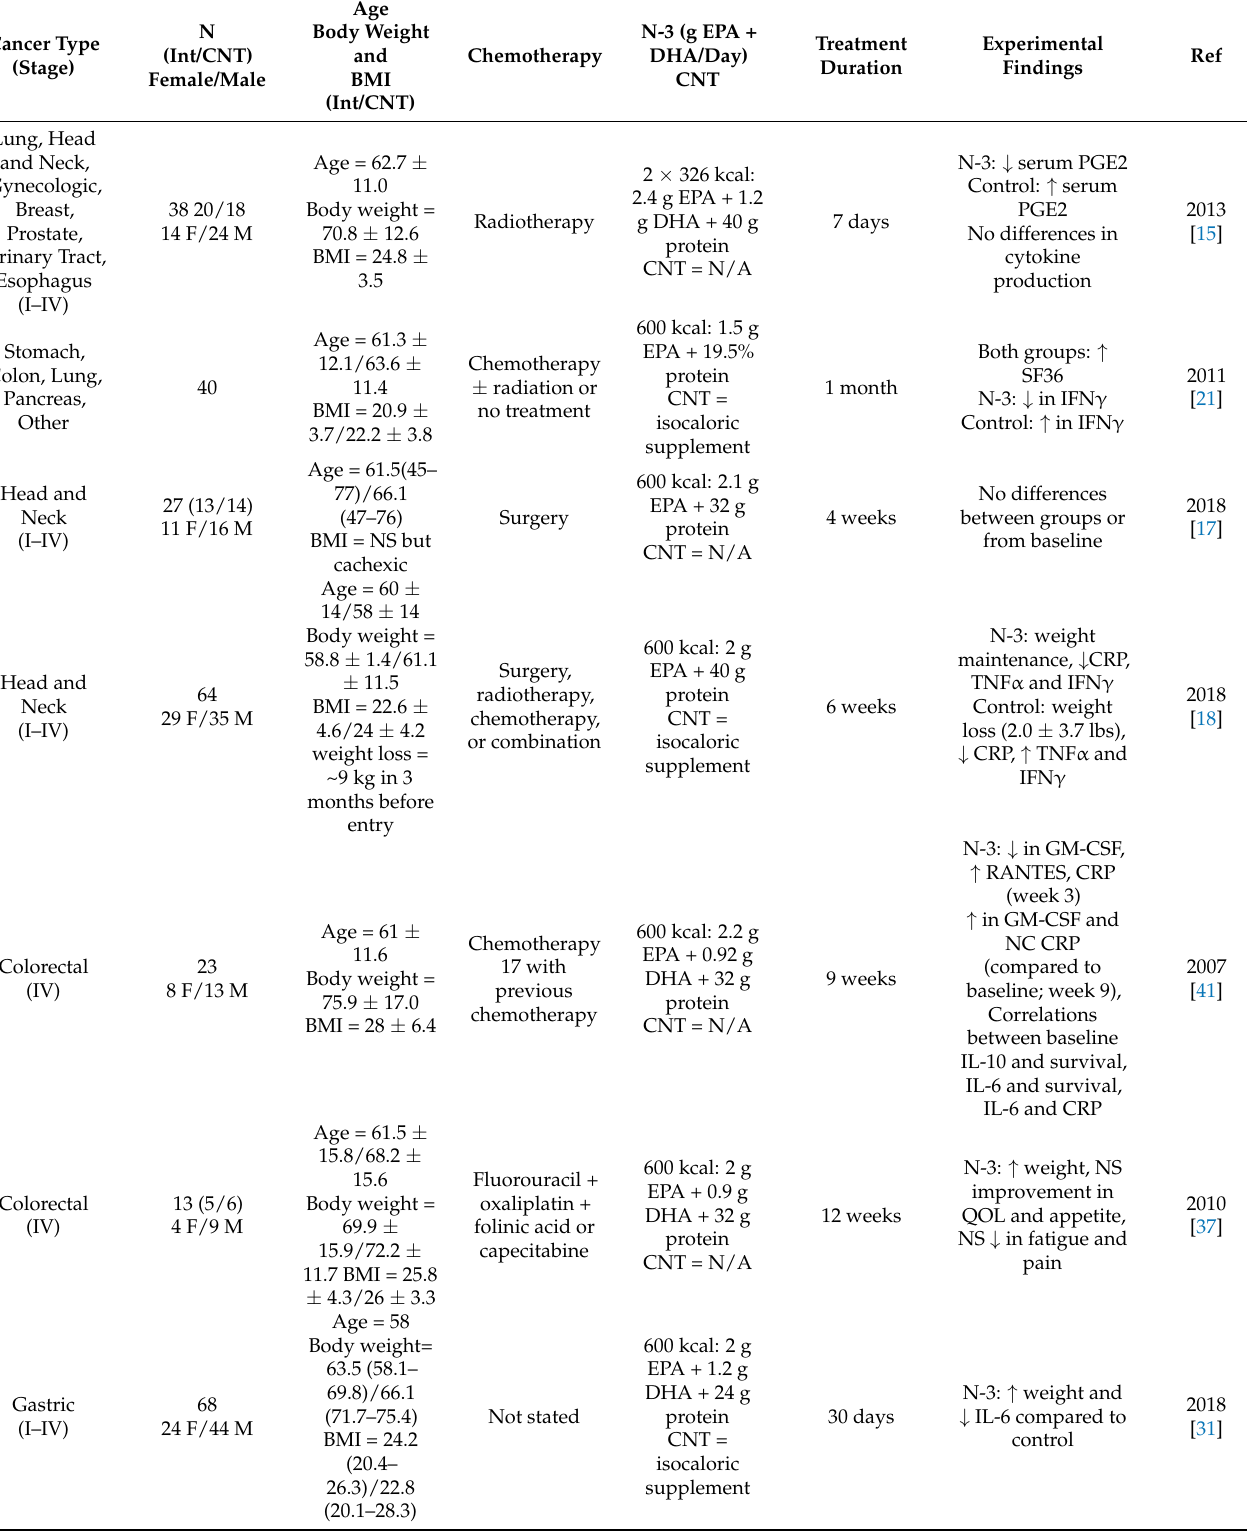
Table 3. Randomized controlled trials providing oral N-3